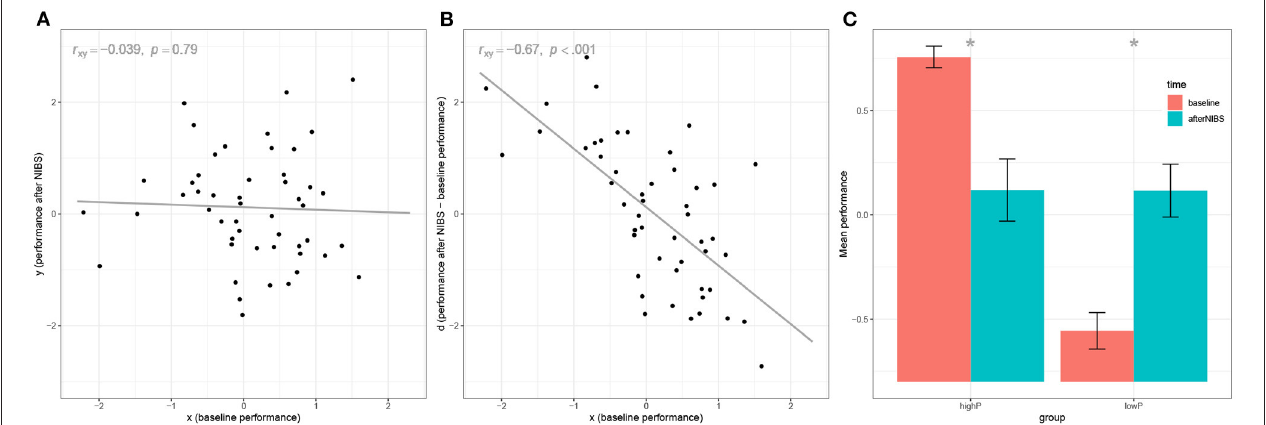
FIGURE 1 | Illustration of mathematical coupling and regression to the mean using a numeric example with N the simulated baseline performance ( x ) and the simulated performance after NIBS ( y ). Data are simulated to be uncorrelated. (B) shows the biases in the correlation approach, by visualizing the relationship between the baseline performance ( x ) and the deviation from the baseline after NIBS ( d ). (C) shows the biases in the categorization approach: The sample is split into high-performers ( highP ) and low-performers ( lowP ) and the baseline performance is compared with the performance after NIBS. Bars represent 1 SE ±